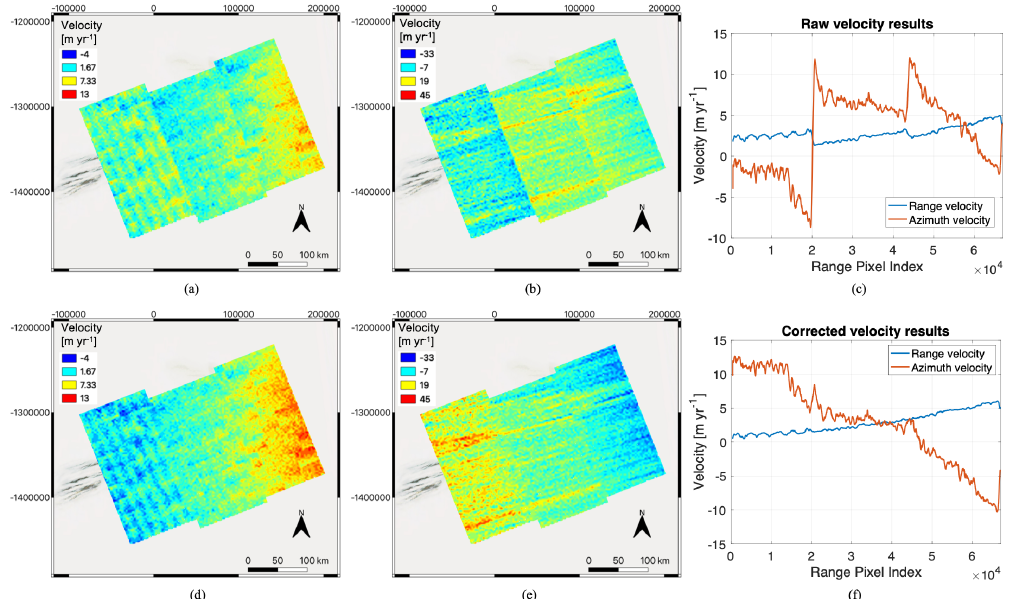
Figure 7. Illustration of subswath-dependent geolocation bias and calibration: (a) raw slant range velocity, (b) raw azimuth velocity, (c) range-dependent variation of raw velocity (averaged for each range line/bin), (d) corrected slant range velocity, (e) corrected azimuth ve- locity, (f) range-dependent variation of corrected velocity (averaged for each range line/bin). The Sentinel-1 image pair 20171226–20180101 in Region 2 is used here. Background: © Microsoft Bing Maps 2022.